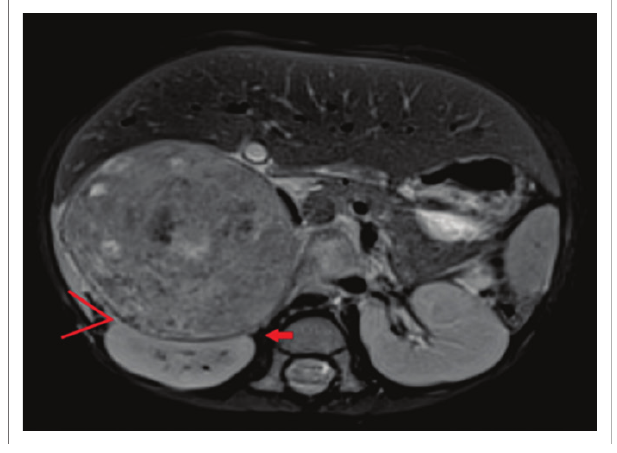
Source : Unedited images were obtained from the radiological information system database (RIS) of Tygerberg hospital while editing and markers seen were added by the author. FIGURE 4: Axial fat-suppressed T2-weighted magnetic resonance image of a neuroblastoma compressing the right kidney. The claw sign is negative with absent tapering, infolding (red arrow) and acute external kidney–tumour